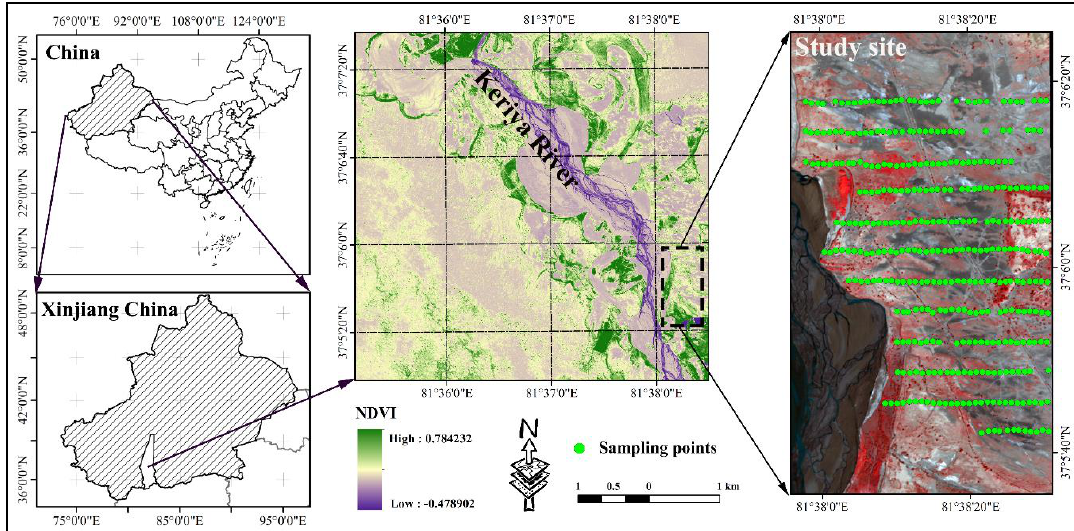
Figure 1. Location of study area and distribution of sampling points.